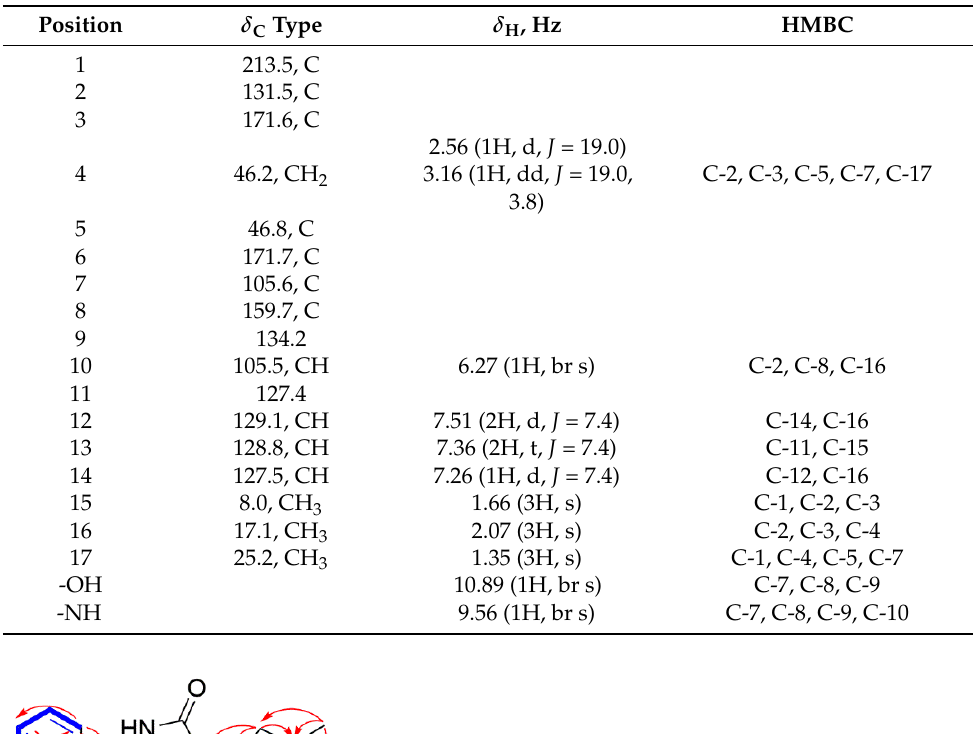
Table 1. NMR data of ( ± ) 1 (400 MHz, DMSO- d 6 , δ in ppm).